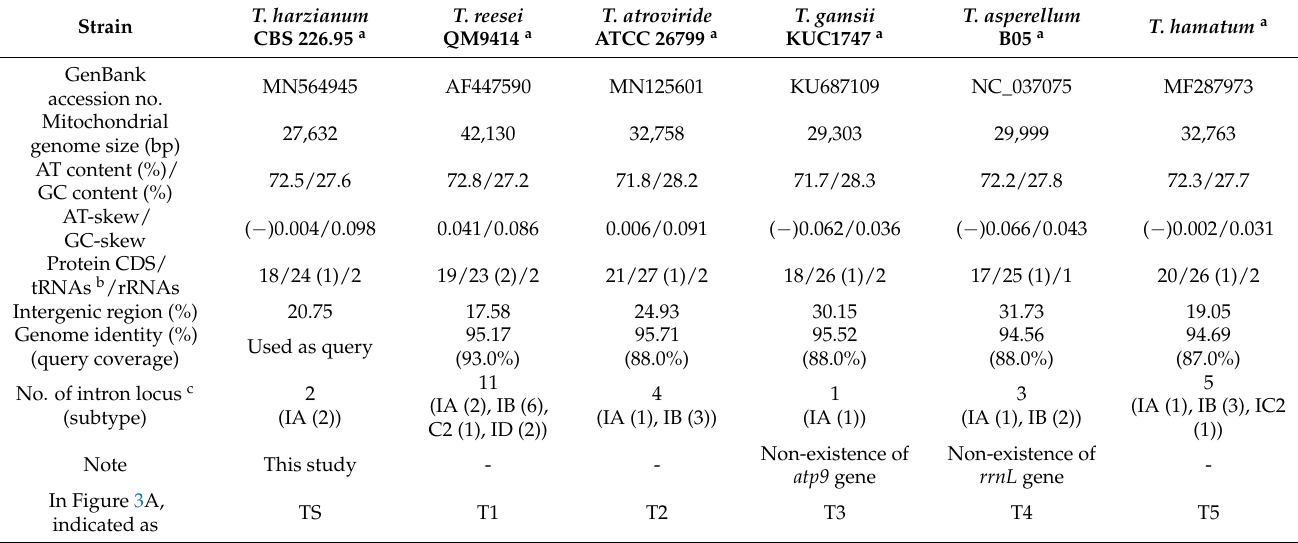
Table 1. Comparison of mitochondrial genomic features among Trichoderma